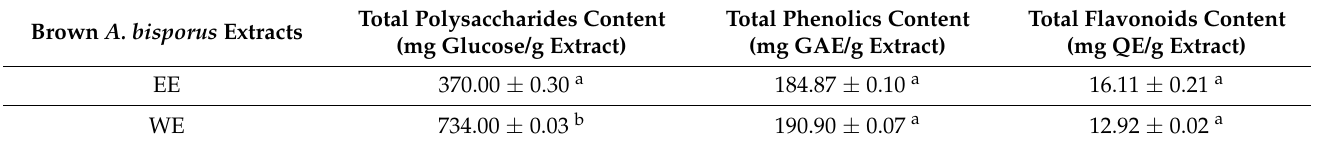
Table 2. The total polysaccharides, total phenolics, and total flavonoids contents of brown A. bisporus ethanol extract (EE) and brown A. bisporus water extract